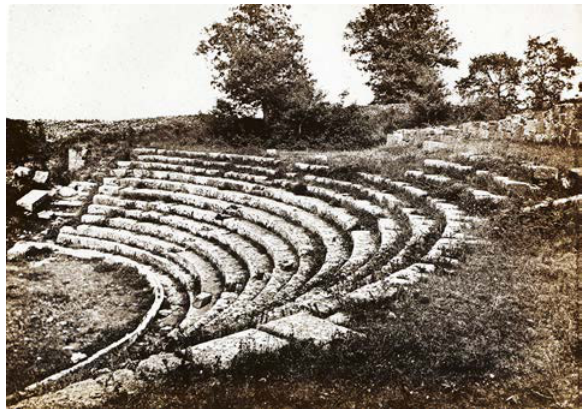
Figure 2. One of the first photographic reproductions of the theater of Tuscolo: John Henry Parker (second half of the 19th century)